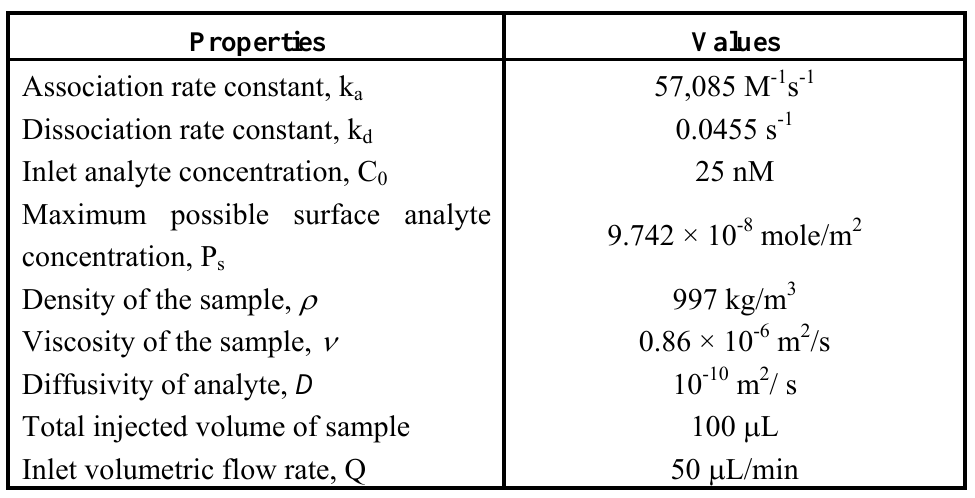
Table 1. Parameters and physical properties used in the